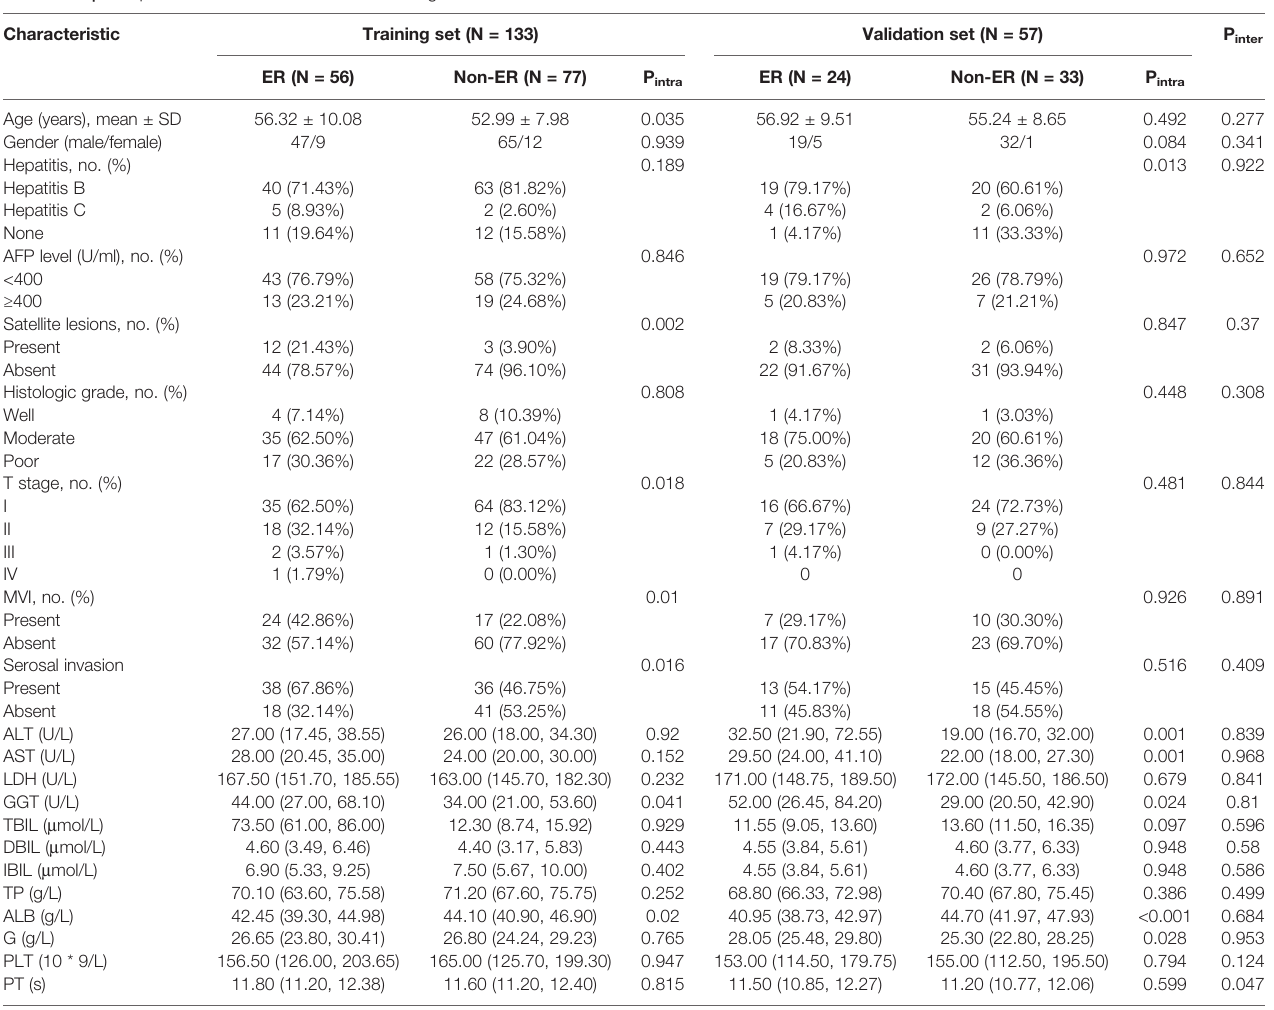
TABLE 1a | Comparisons of clinical factors in the training and validation sets.